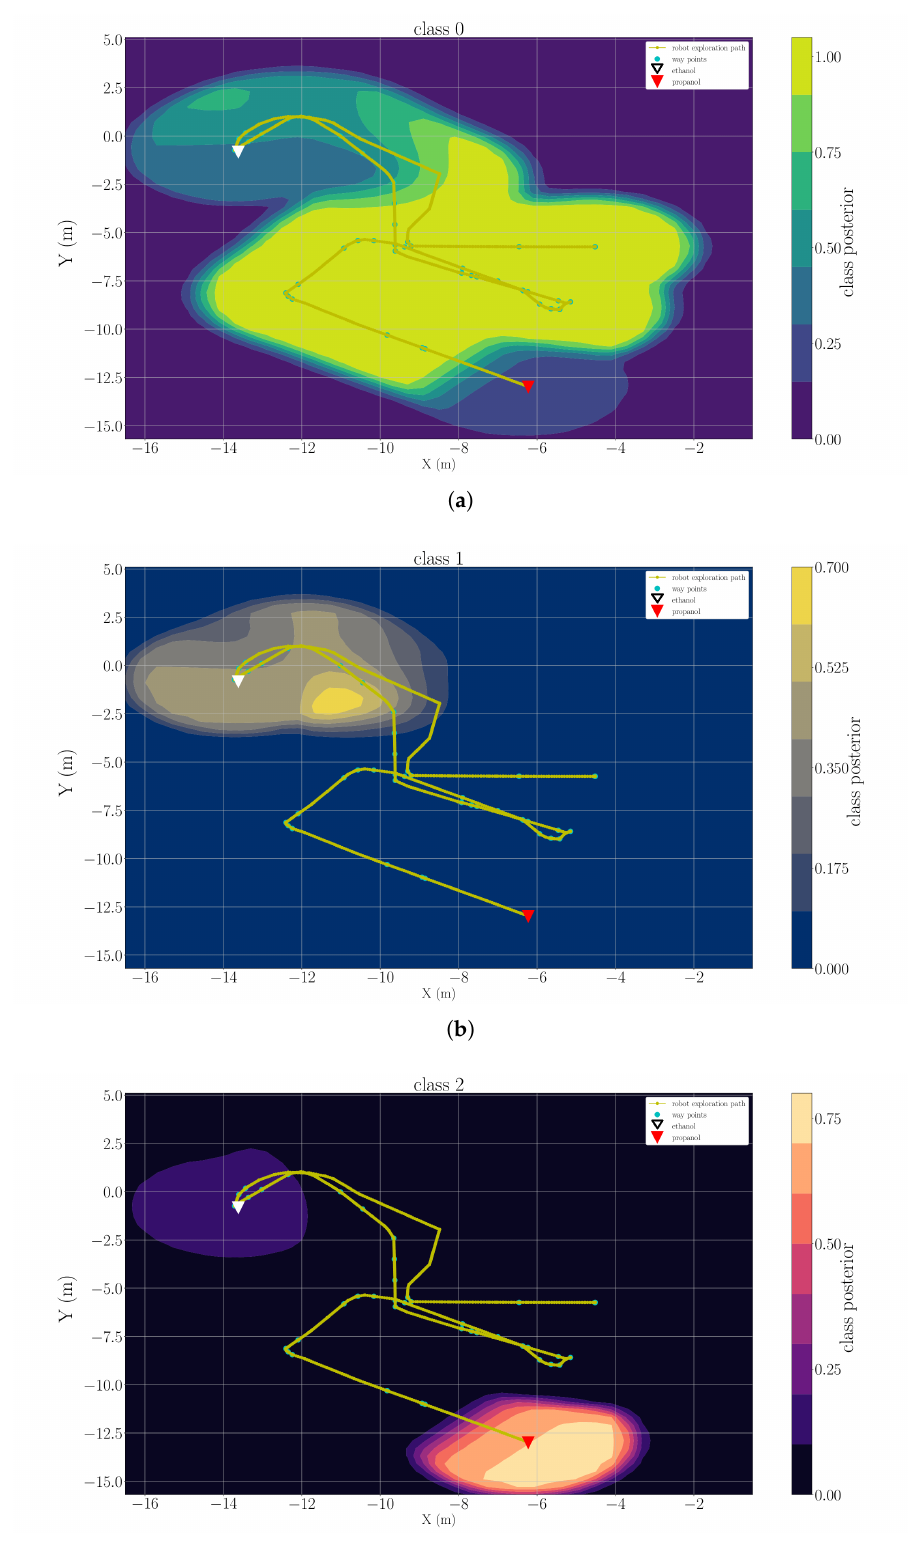
Figure 14. A snapshot of the classification map learned for clean air ( a ), ethanol ( b ) and acetone ( c ) in the trial Experiment